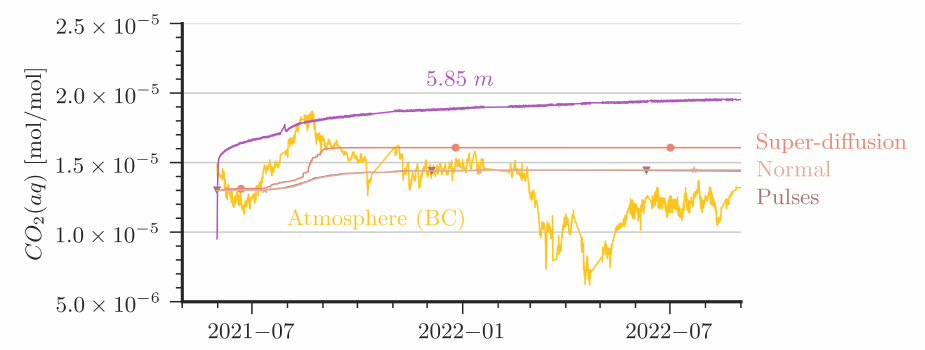
Figure 8. Comparison of aqueous CO 2 concentrations between measurement and simulations at 5.85 m depth (bottom). In addition, atmospheric CO 2 is plotted to show the driving force of the system. ‘Pulses’ and ‘Normal’ show the same